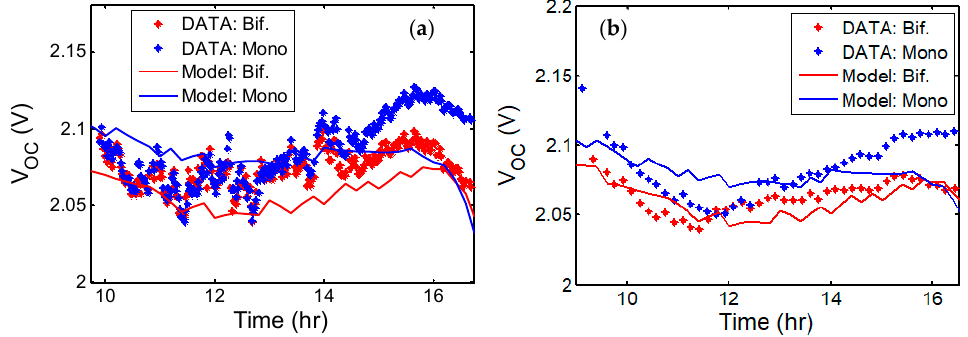
Figure 6. Data of a single day of module V OC compared with the values predicted by the model ( a ) and average values compared with the model ( b ).